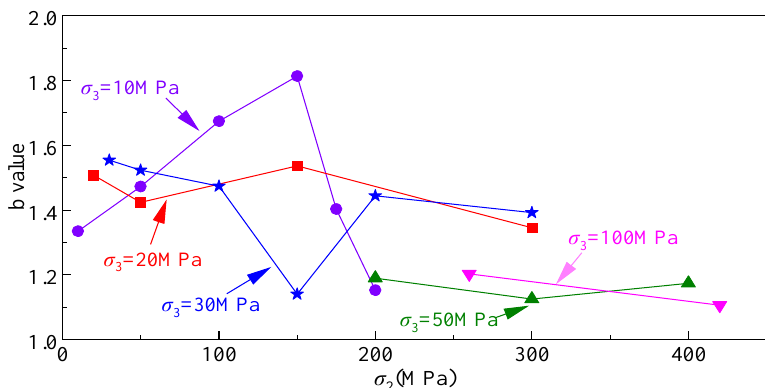
Figure 10. b value in different granite specimens under true triaxial stress.